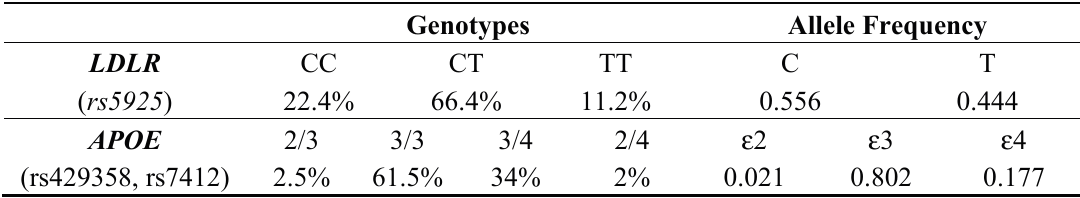
Table 2. Genotype distribution and relative allele frequencies for the polymorphisms studied in Amerindian hypercholesterolemic subjects ( n = 116).